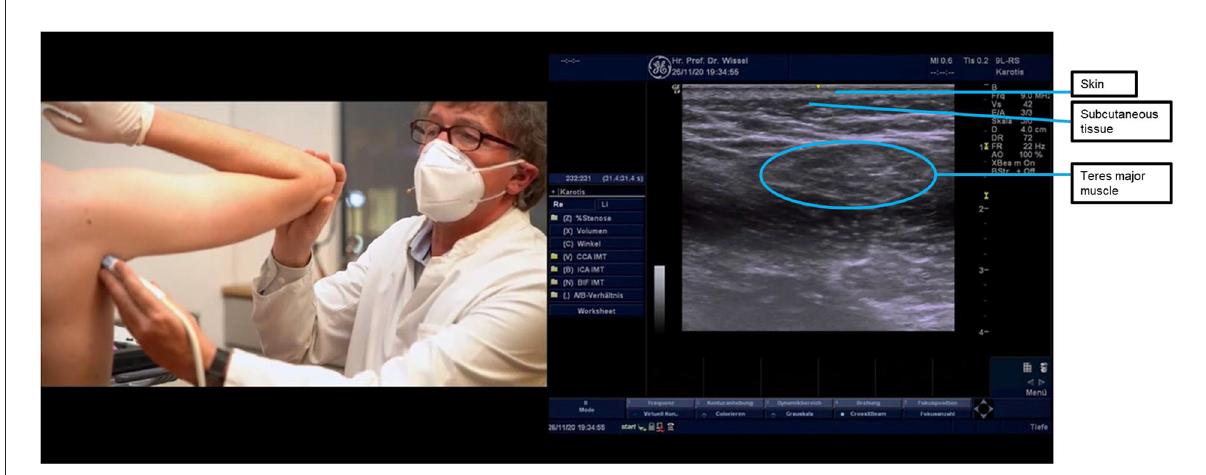
FIGURE3 Ultrasound probe placement and image of the teres major muscle. The round muscle in the middle of the ultrasound image is the teres major muscle. The ultrasound probe can be turned through 90 degrees to help identification, with the teres major muscle having a striped appearance when the ultrasound probe is placed longitudinally.